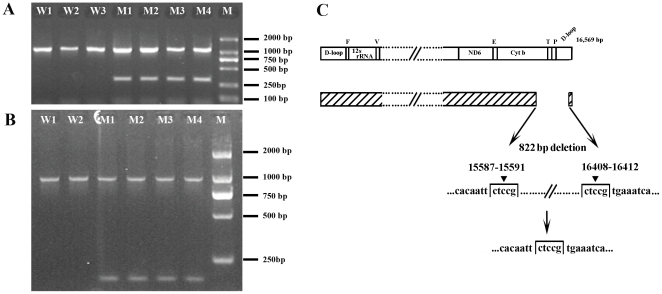
Electrophoresis for the detection of the 822 bp mtDNA deletion and the 822 bp mtDNA deletion in the schematic representation of a linearized mitochondrial genome.(A) PCR products amplified with primers mtDNA-1 and mtDNA-2. The right lane is molecular marker DL 2000. W1, W2, and W3 showing PCR products with 1129 bp from wide type mtDNA, M1, M2, M3 and M4 indicating PCR products with 1129 bp and 307 bp from mutant mtDNA. (B) PCR products amplified with primers mtDNA-1 and mtDNA-3. The right lane is molecular marker DL 2000. W1 and W2 showing PCR products with 956 bp from wide type mtDNA, M1, M2, M3 and M4 indicating PCR products with 956 bp and 134 bp from mutant mtDNA. (C) The 822 bp mtDNA deletion in the schematic representation of a linearized mitochondrial genome. Mitochondrial nucleotides were numbered according to rCRS of mtDNA [30]. Nucleotide repeats at or near the sites of cleavage are bracketed. The placement of ▾ above the bracket indicates that the exact cleavage site within the nucleotide repeat was unknown. The deleted mtDNA fragment covered from 15587–15591 nps to 16408–16412 nps. CTCCG showed the 5 bp short direct repeats at both ends of the deletion regions. The deletion was formed by cleavage within the 5 bp direct repeats.